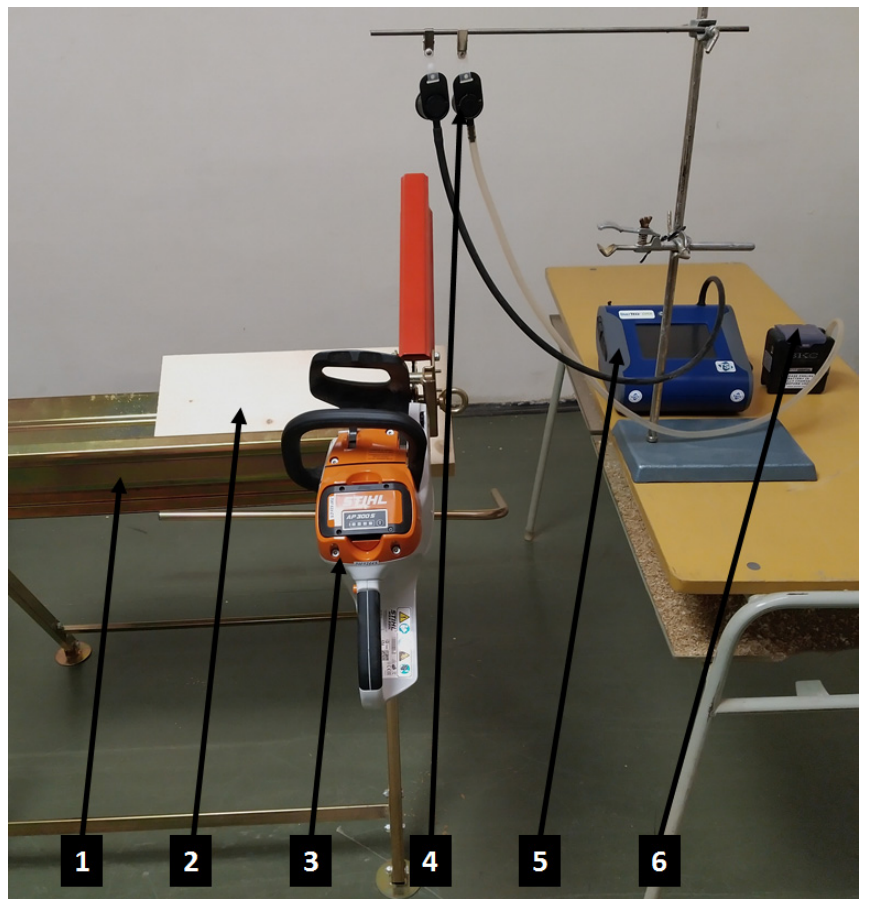
Figure 1. Layout of the experimental setup: 1—sawhorse with chainsaw holder, 2—test specimen, 3—chainsaw, 4—IOM sampler, 5—aerosol monitor, 6—pump.